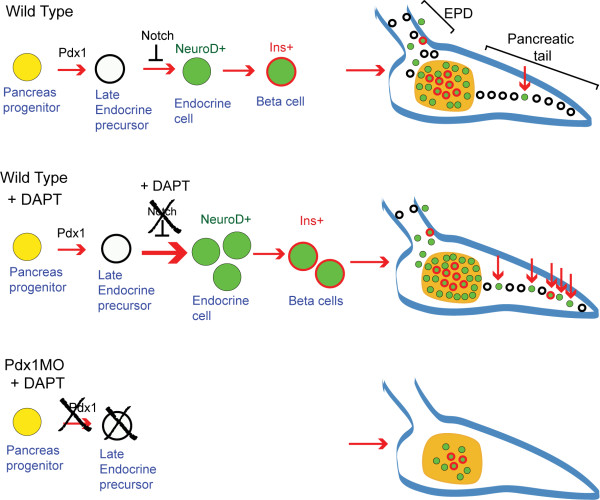
Schematic of Notch-responsive progenitors. In wild-type embryos (top), an early pancreatic progenitor (yellow) gives rise to early endocrine cells (green) as well as progenitors for late endocrine cells (white) located in the extrapancreatic duct (EPD) and pancreatic tail. Notch signaling maintains these latent progenitors in an undifferentiated state. Inhibition of Notch signaling by treatment with N-[N-(3,5-difluorophenacetyl)-L-alanyl]-S-phenylglycine t-butyl ester (DAPT) (center) activates differentiation of the latent progenitors, leading to new endocrine cell formation in the principal islet and pancreatic tail (red arrows). In pdx1 morphants (bottom), early endocrine specification occurs but Notch-responsive progenitors for late endocrine cells are absent or hindered in differentiation, which can be demonstrated by treatment with DAPT.